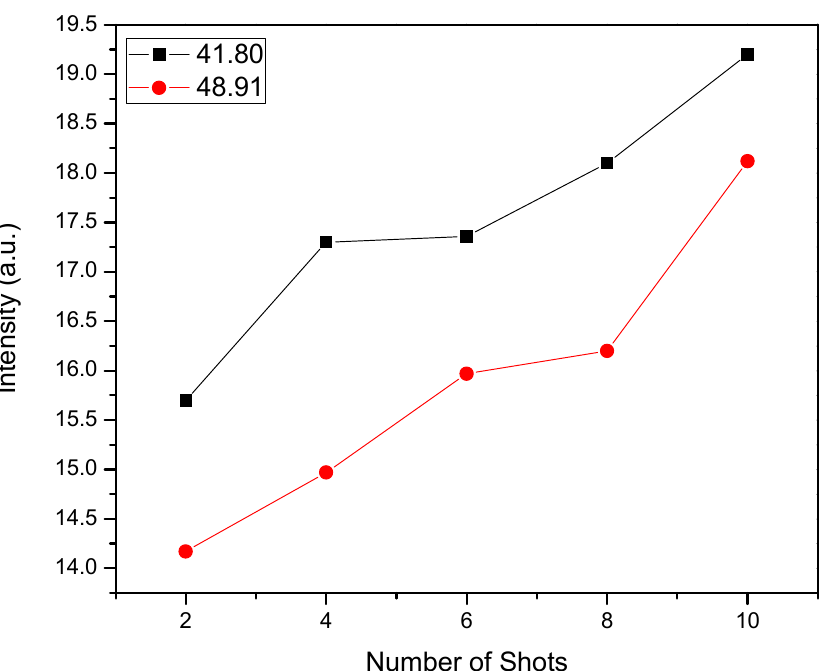
Figure 3. Variation in intensity recorded for PTFE-coated Ti samples as a function of number of shots.